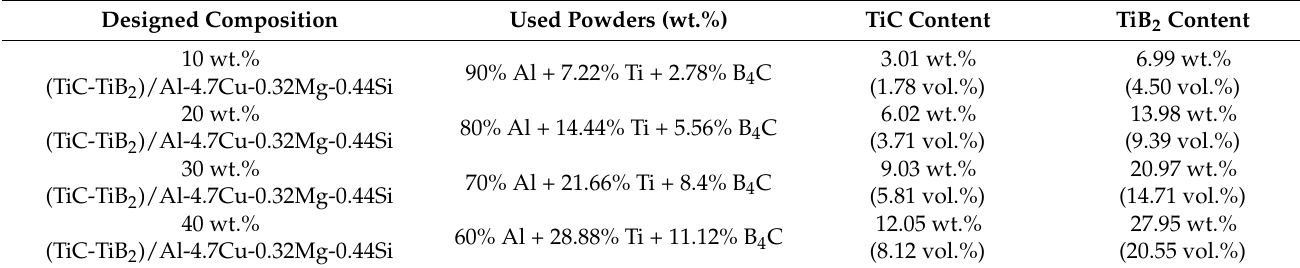
Table 1. Characteristics of the in situ TiC-TiB 2 /Al-Cu-Mg-Si nanocomposites synthesized in Al-Ti-